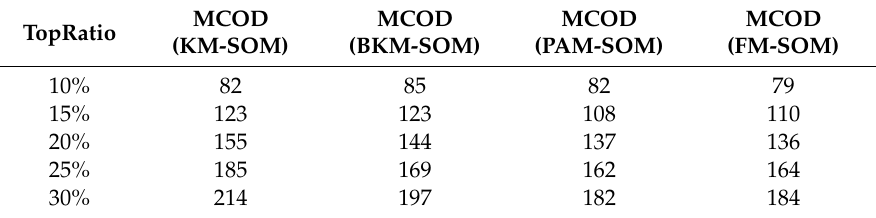
Table 8. Number of Detected Outliers for the Cardio Dataset (MCOD).